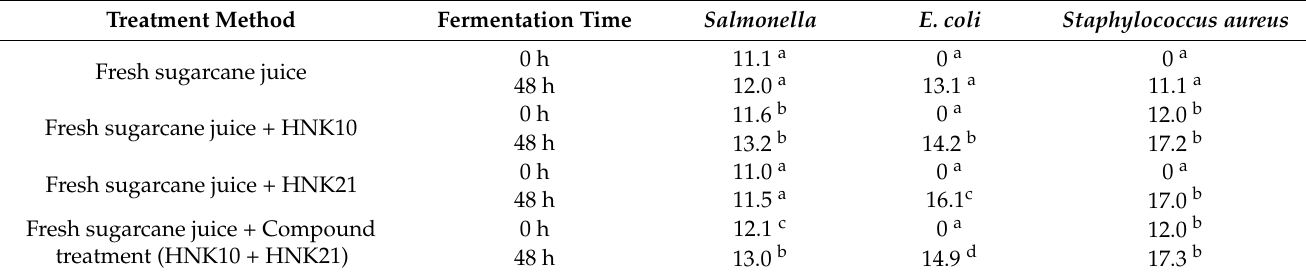
Table 3. Bacteriostatic ability of sugarcane juice during fermentation (unit: